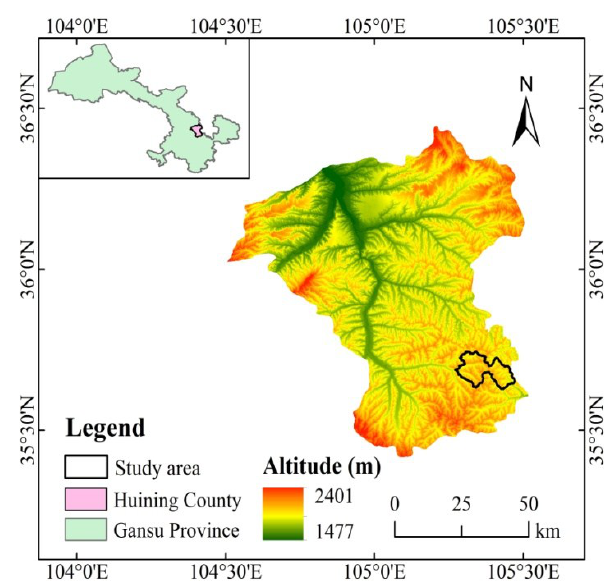
Figure 1. The study area in Huining County, Gansu Province, China.